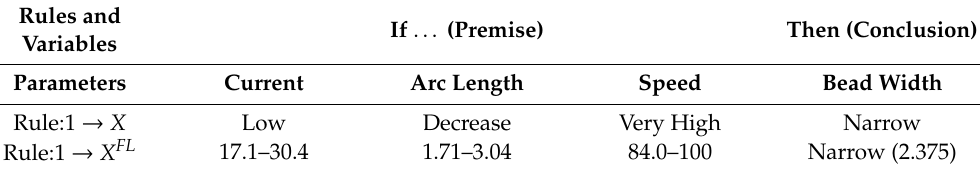
Table 4. Modified expert rules using a fuzzy Likert algorithm.